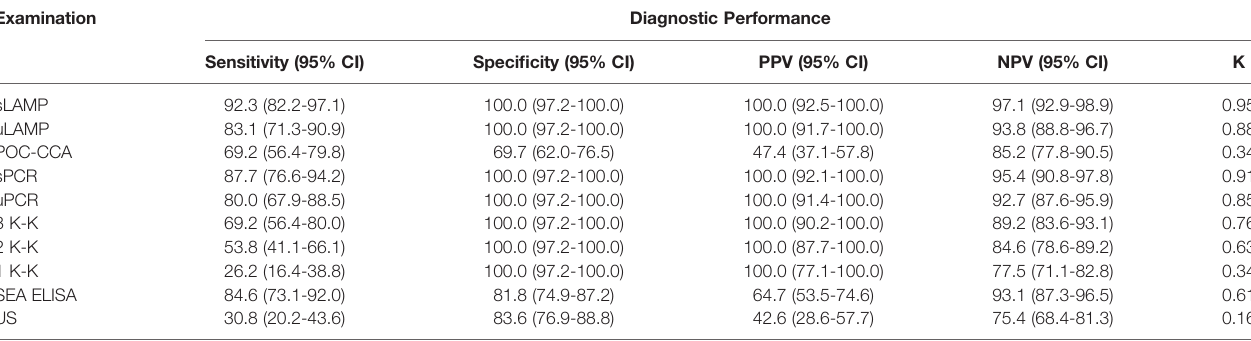
Sn,Sensitivity;Sp,Speci fi city;PPV,PositivePredictiveValue;NPV,NegativePredictiveValue;K,KappaCoef fi cient;sLAMP,SerumLAMP;uLAMP,UrineLAMP;POC-CCA,Point-of-care circulating cathodic antigen urine test; sPCR, Serum PCR; uPCR, Urine PCR; 3 K-K, Three stool Kato-Katz; 2 K-K, Two stool Kato-Katz; 1 K-K, Single stool Kato-Katz; (SEA) ELISA, Soluble Egg Antigen; US, Ultrasound.